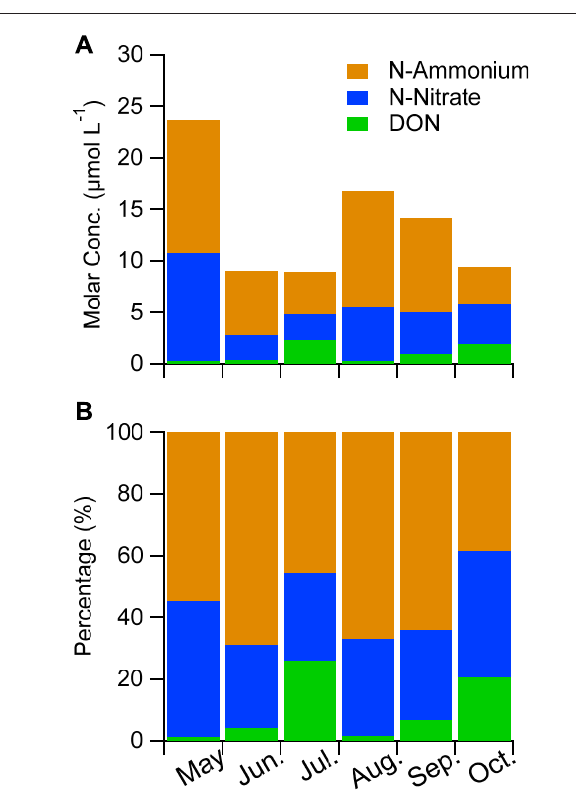
FIGURE 4 | (A) Monthly mean total dissolved nitrogen concentrations (µmol L − 1 ) and (B) molar contribution of different nitrogen species in different categoriesofsamplescollectedfromtheDKMDGlacierasshownin Figure3